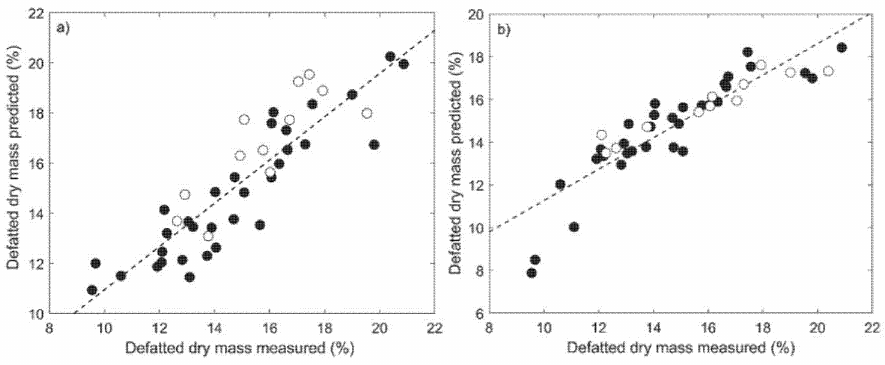
Figure 3. Plots of reference versus predicted values for the calibration (black circles) and validation (white circles) samples for ( a ) CMPG and ( b ) CWFP-T 1